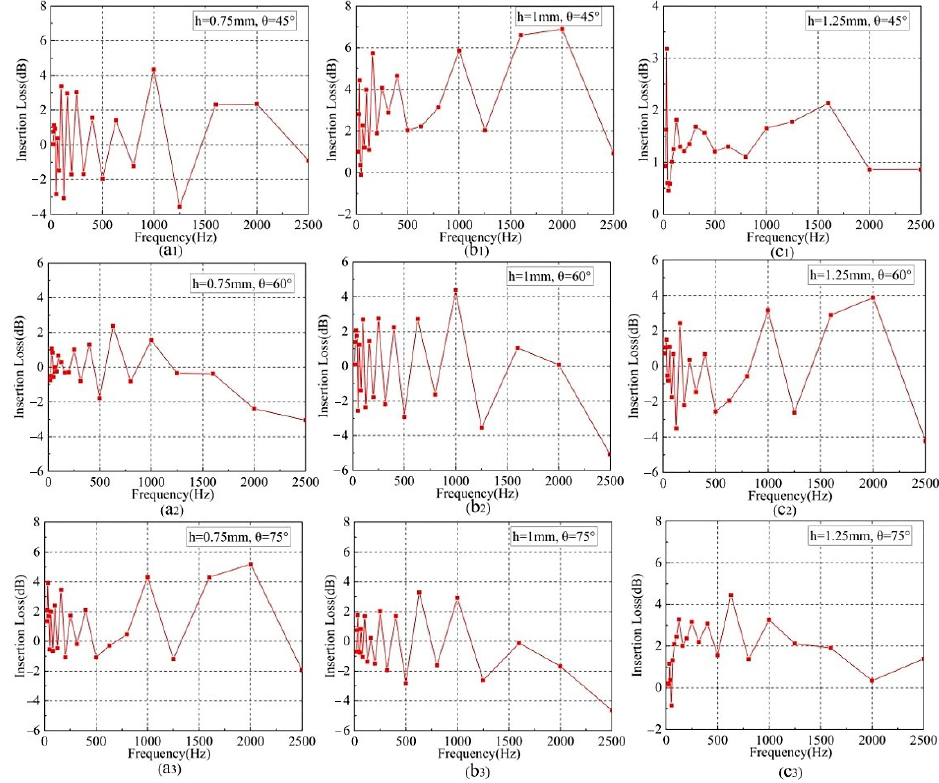
Figure 21. Insertion loss curves at different size parameters: ( a 1 – a 3 ) texture height h 0.75 mm and top angle θ 45 °– 75 ° , ( b 1 – b 3 ) texture height h 1mm and top angle θ 45 °– 75 ° , ( c 1 – c 3 ) texture height h 1.25 mm and top angle θ 45 °– 75 ° .